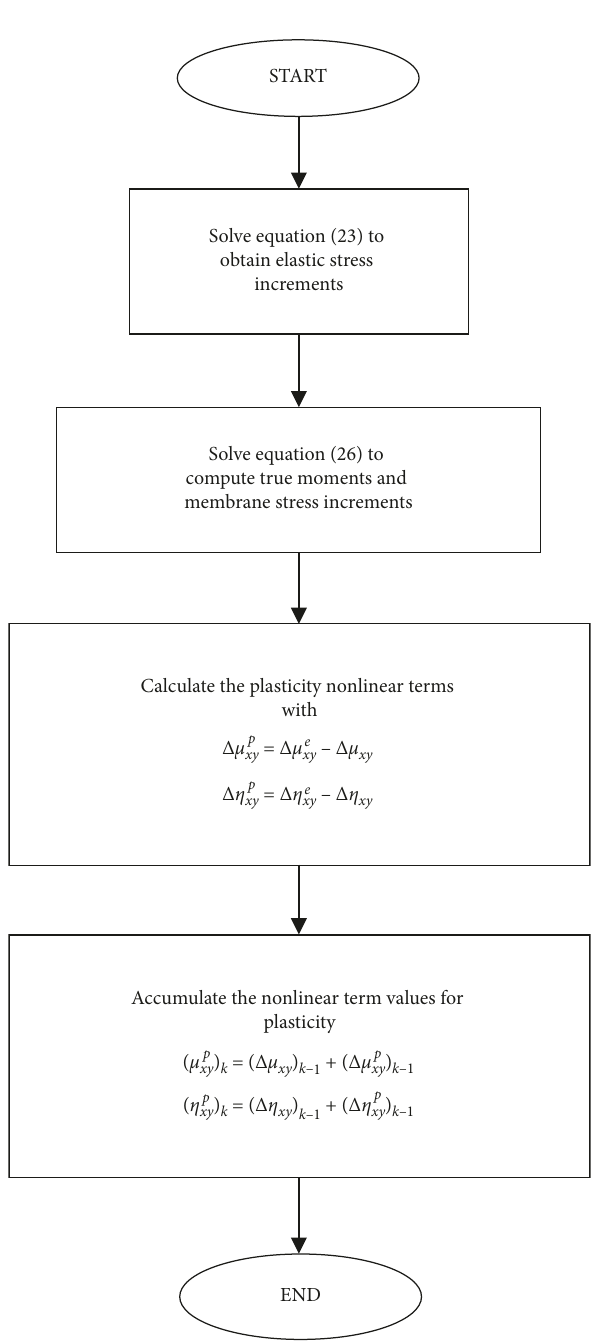
Figure 1: Procedure to calculate the nonlinear terms due to